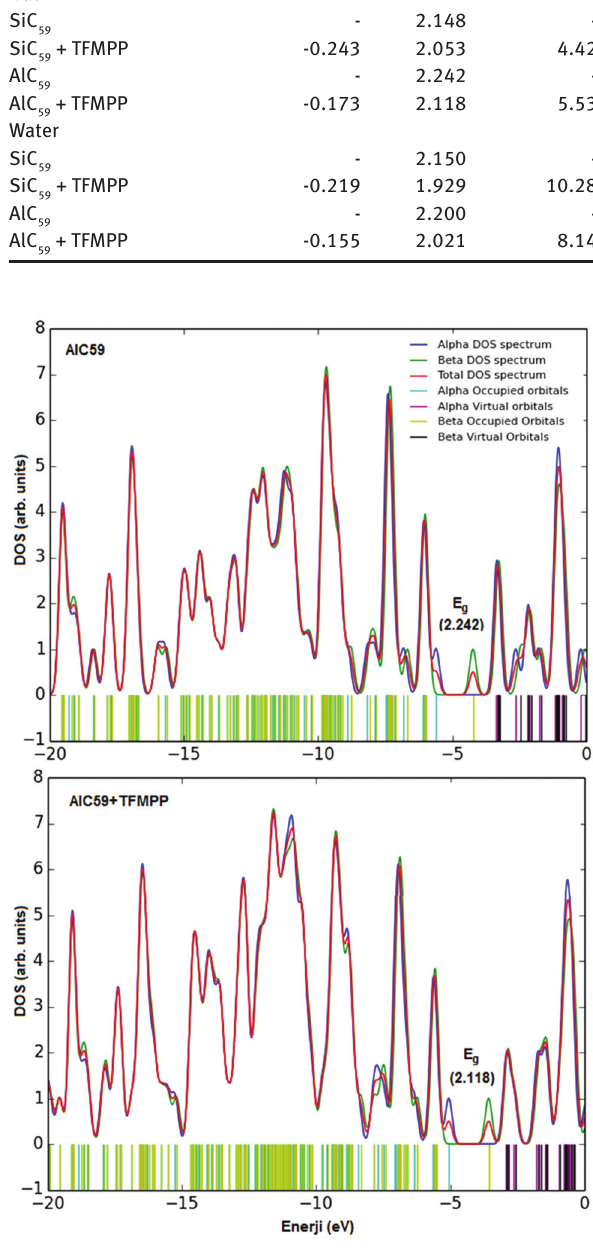
and AlC +TFMPP 59 59